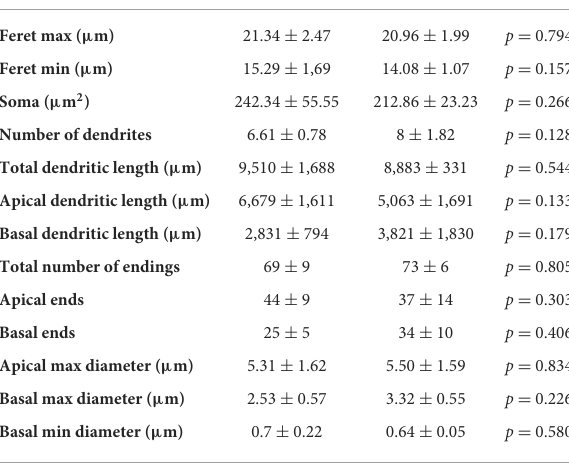
TABLE 2 Somatic and dendritic morphological properties of RB pyramidal cells of WT and reeler